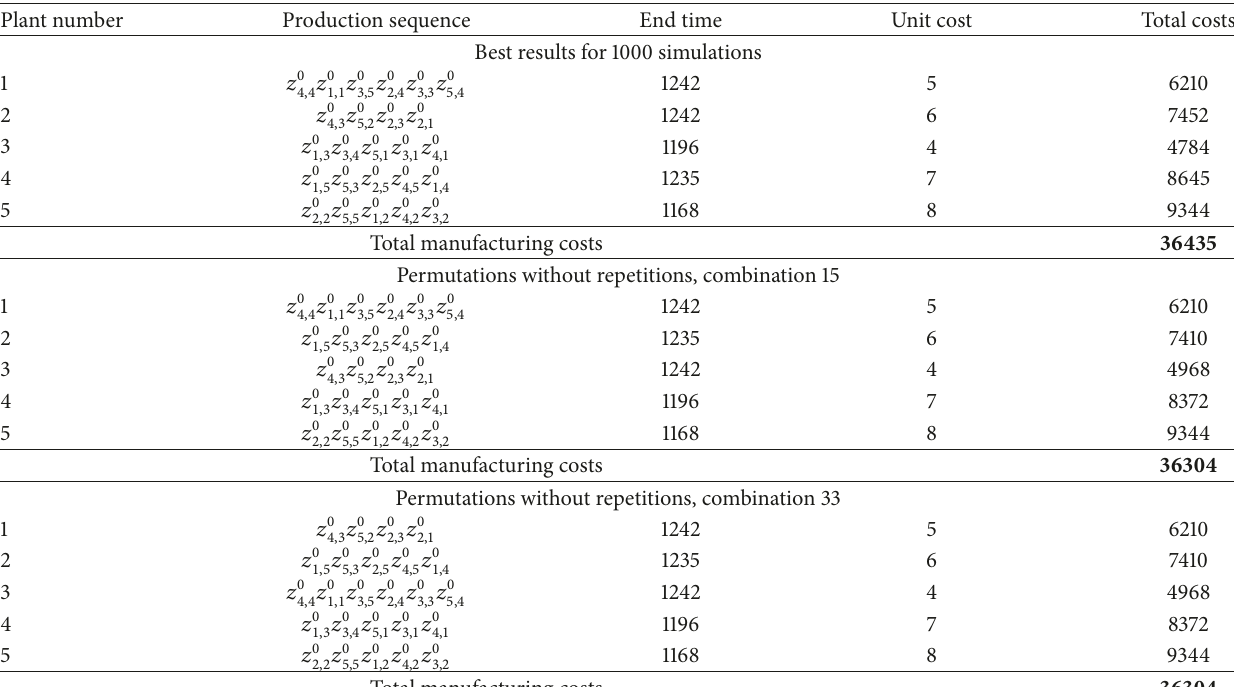
Table 8: Manufacturing costs in case of the immediate strategy in the 5-plant system. Plant